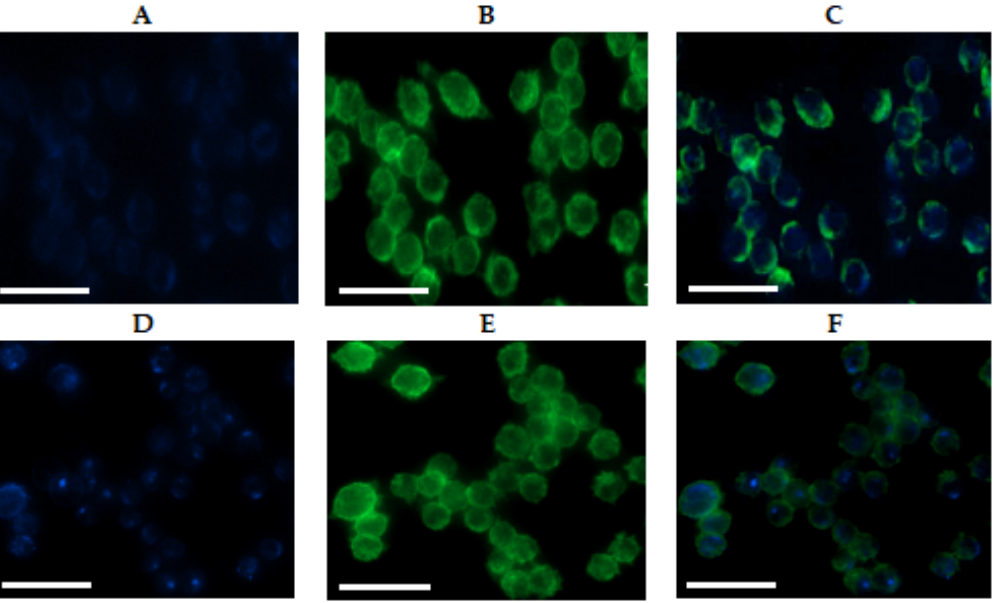
Figure 7. Fluorescence images of J7741.A cells treated for 3 h with: ( A – C ) hybrid PGlu@Ag nano- particles labeled with Cy5; ( D – F ) Cy5-P(Glu-co-Phe) nanoparticles. The images from left to right show the fluorescence of Cy5-labeled nanoparticles in cells (blue), the stained cell membrane (green), and the overlap of two images (scale bar equal to 50 µm).